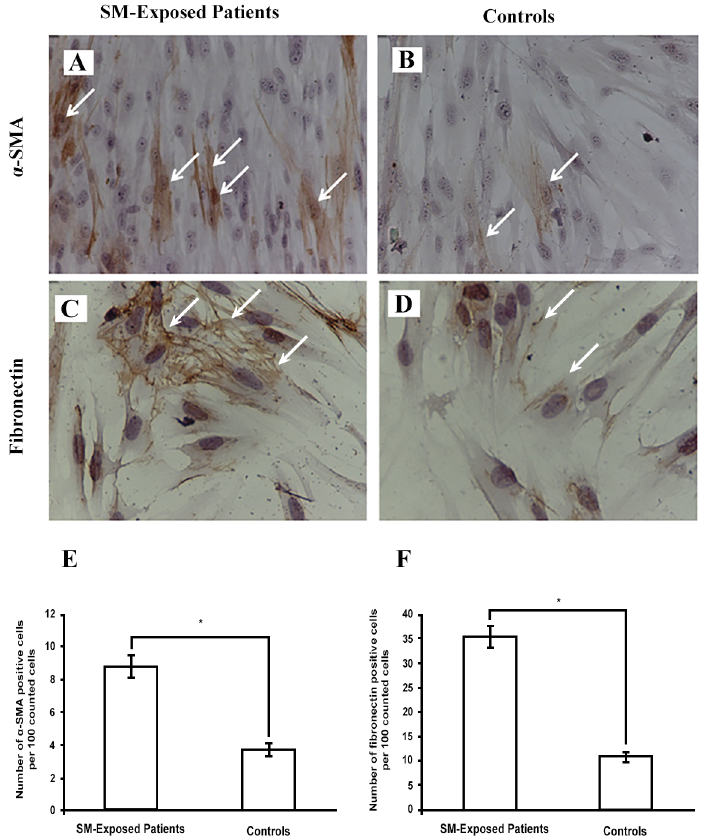
Fig 2. Immunocytochemical detection of α -SMA and fibronectin expression. Both SM-exposed patients and controls expressed α -SMA (A and B, 10×) and fibronectin (C and D, 20×). The number of positive cells was determined by enumeration of 100 cells/sample. Figures E and F present the count of positive cells as mean ± SEM for patients (n = 5) and controls (n = 4). * p < 0.0001. Arrows show positive cells; Abbreviations: α -SMA alpha smooth muscle actin, SM sulfur